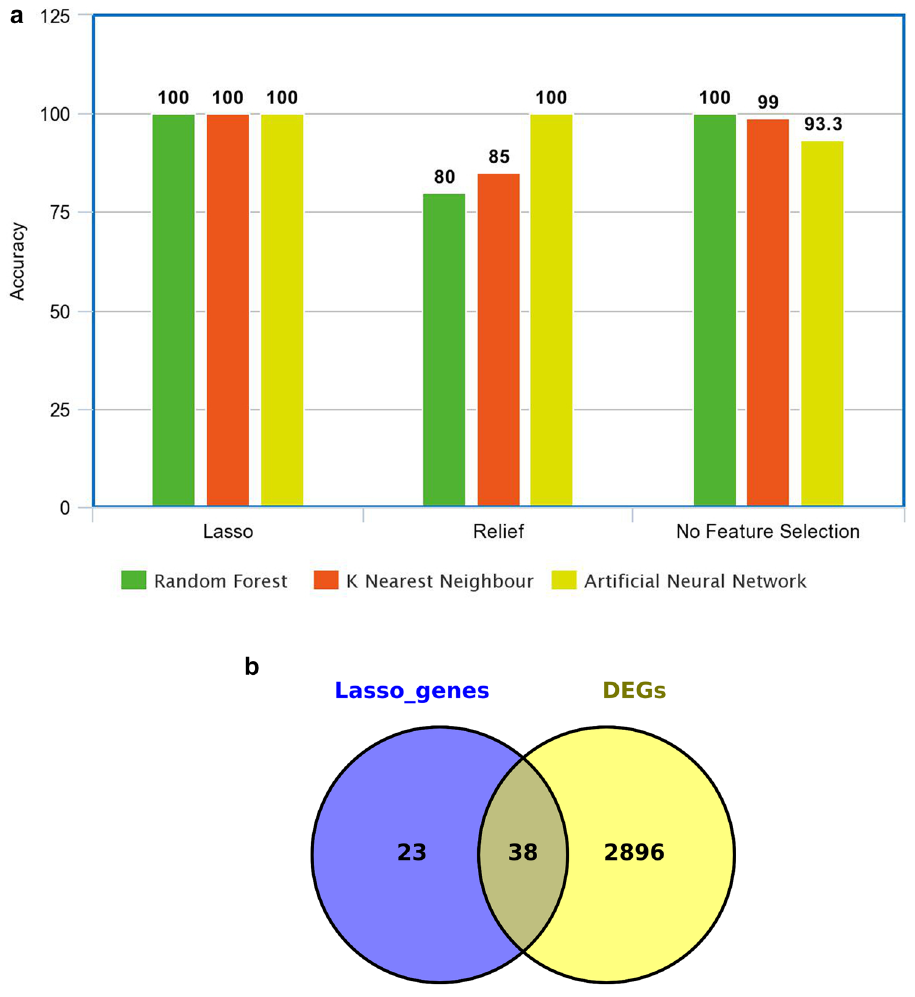
Figure 6. ML analysis of the CRC dataset. ( a ) Accuracy of the selected ML algorithms. ( b ) Venn diagram of a common set of overlapping genes obtained from ML approach and